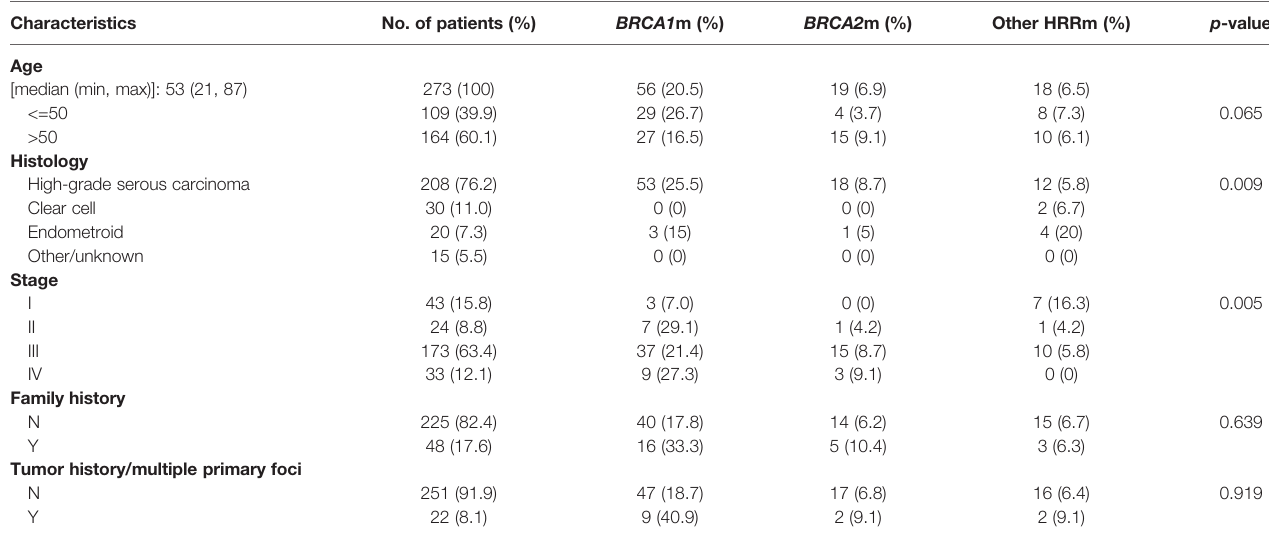
TABLE 1 | The major clinicopathological characteristics, BRCA1/2 , and other HRR gene mutations in epithelial ovarian cancers.